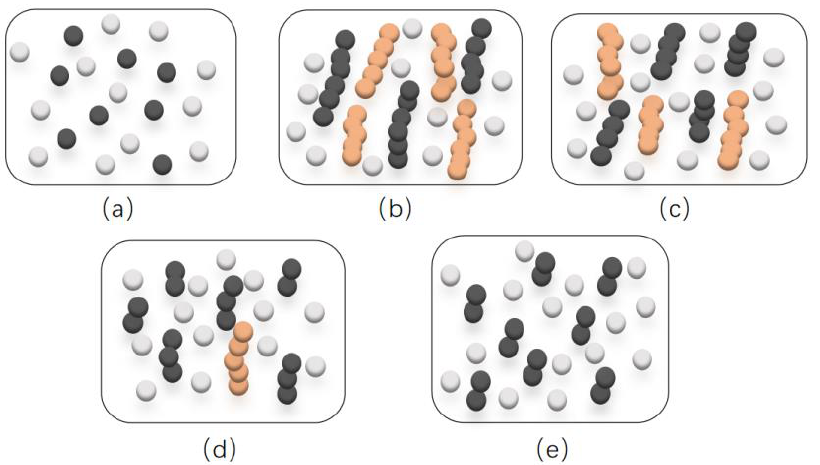
Figure 6. Schematic of the microscopic process of applying a magnetic field and strain: ( a ) equilibrium state; ( b ) the state in which a magnetic field is applied; ( c ) the state in which the strain is applied; ( d ) the state of increasing strain; ( e ) the state of the ultimate strain. “Reprinted/adapted with permission from Ref. [21]. 2019, Mishra, A.; Pathak, S.; Kumar, P.; Singh, A.; Jain, K.; Chaturvedi, R.; Singh, R.; Singh, D. ”.